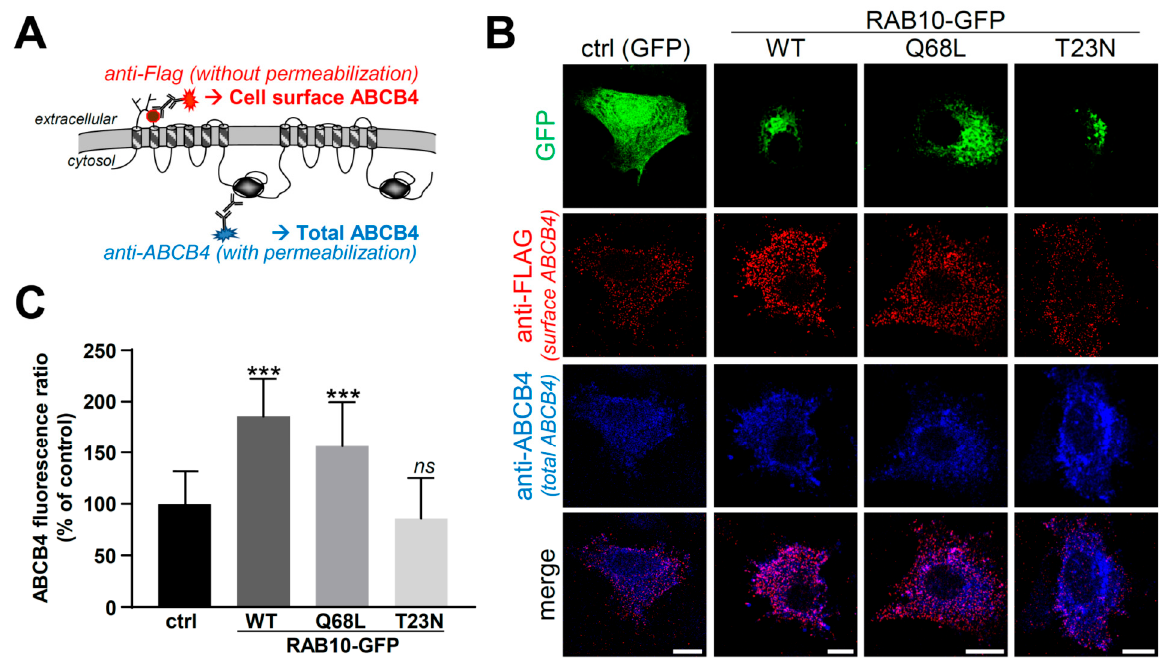
Figure 3. Analysis of ABCB4 localization at the plasma membrane after RAB10 overexpression in HeLa cells. ( A ) Schematic representation of the indirect immunofluorescence approach allowing the discrimination of cell surface (red) vs. total (blue) ABCB4 using anti-FLAG antibodies before permeabilization and anti-ABCB4 antibodies after permeabilization, respectively. ( B ) ABCB4-FLAG and the indicated RAB10 forms were expressed in HeLa cells. After 48 h of expression, the cell surface and total ABCB4 were labeled as schematized in (A). After immunolabeling, cell surface ABCB4 (red), total ABCB4 (blue) and RAB10-GFP (green; GFP alone for control) were visualized by confocal microscopy. This panel is representative of three independent experiments. Bars: 10 µm. ( C ) Quantification of (B). Fluorescence ratio of cell surface ABCB4/total ABCB4 was determined and represented as a percentage of the control condition (GFP alone-expressing cells). For each condition, at least 90 independent cells from three independent experiments were analyzed. Means (±SD) are represented; *** p < 0.005; ns: not significant.